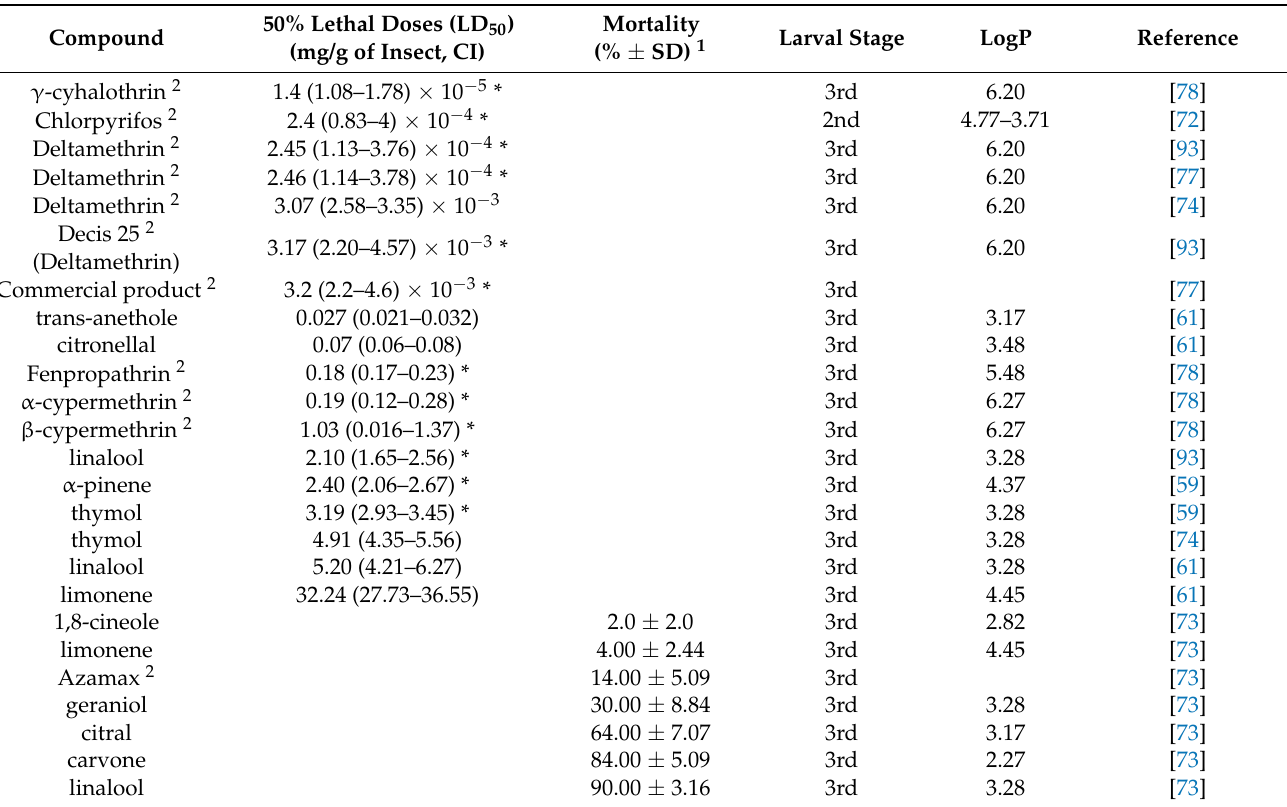
Table 9. Lethal effects of pure compounds tested, on Spodoptera frugiperda , by topical